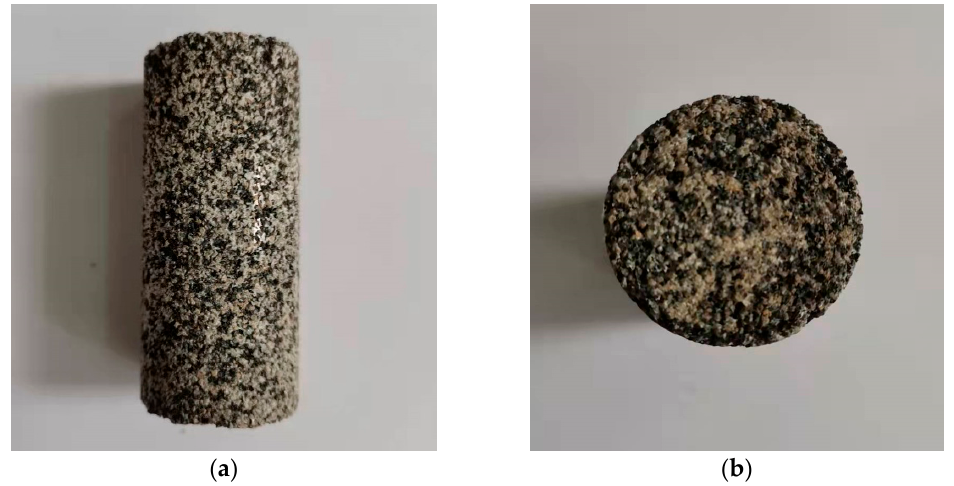
Figure 1. The Core column of SCGPCS. ( a ) Longitudinal section. ( b ) Cross-section.